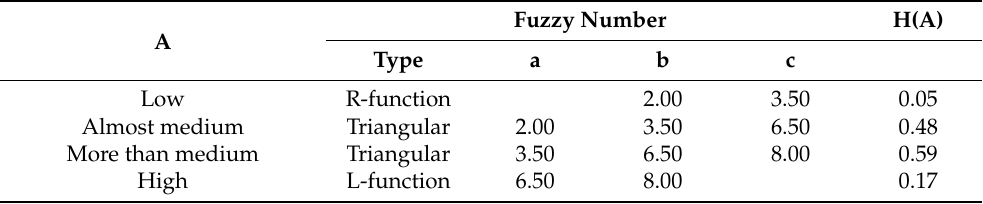
Table 5. Fuzzy sets in the fuzzy partition in Figure 9 and their fuzziness.